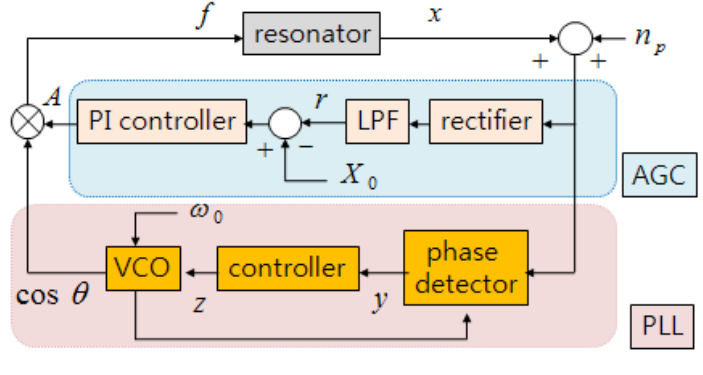
Figure 1. Block diagram of frequency tracking and amplitude